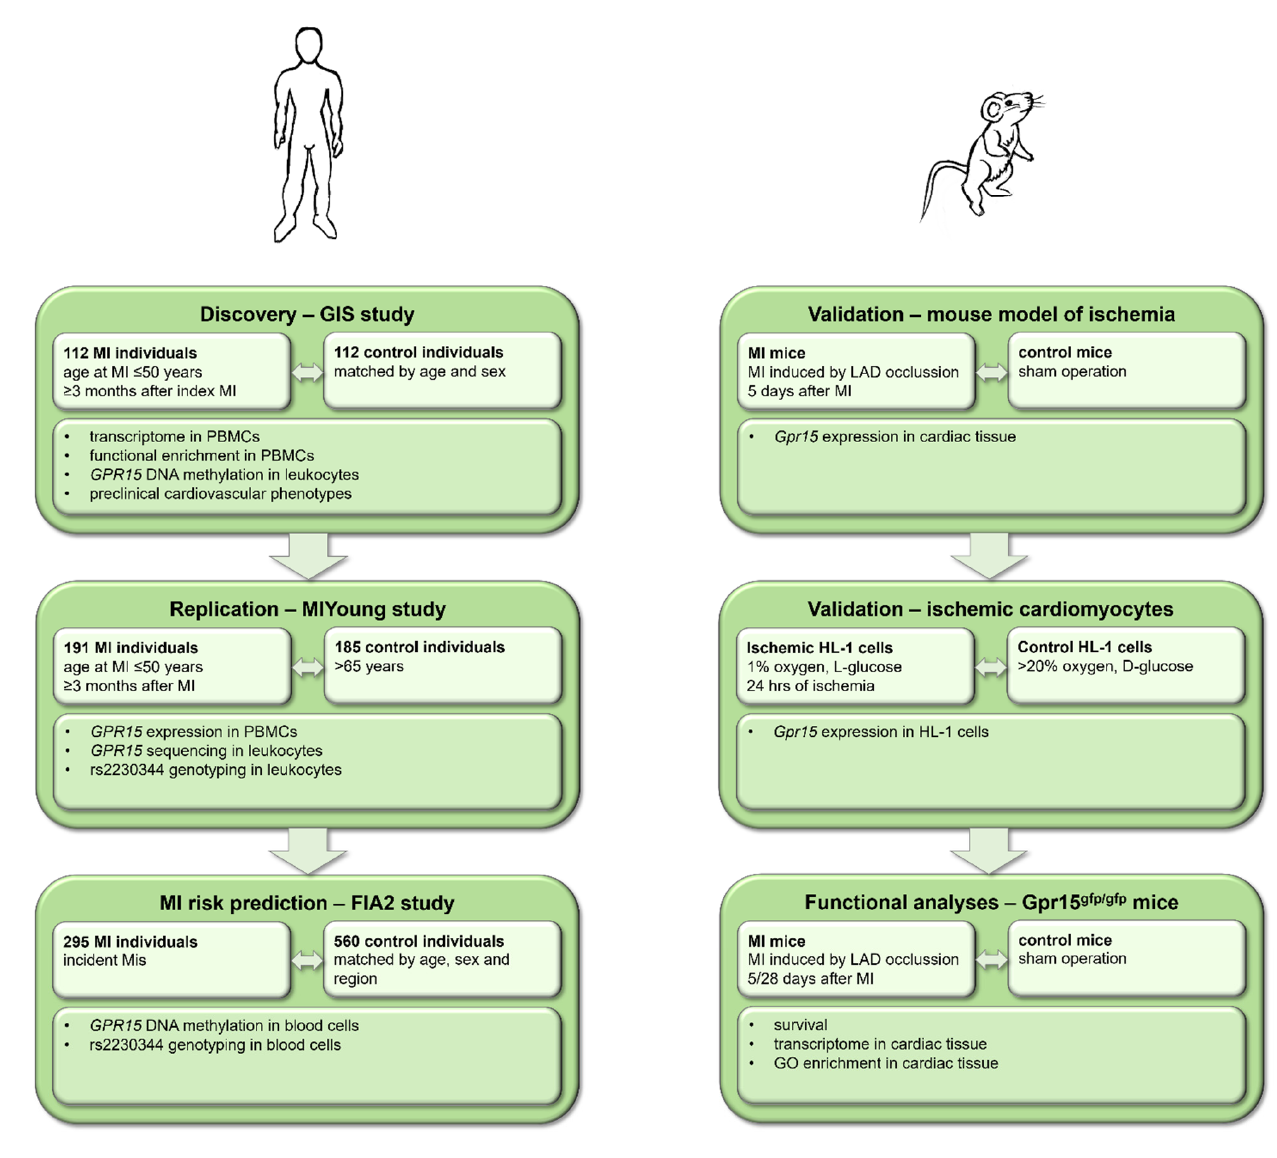
Figure 1. Study workflow including data from human studies and mouse experiments. In a transla- tional approach, human data from the GIS and MIYoung studies were used for the discovery and replication of results, whereas data from the FIA2 study were analyzed for myocardial infarction (MI) risk prediction. Experimental validation and functional analyses were performed in mouse models of ischemia, ischemic cardiomyocytes and Gpr15 gfp/gfp mice. PBMCs = peripheral blood mononuclear cells.